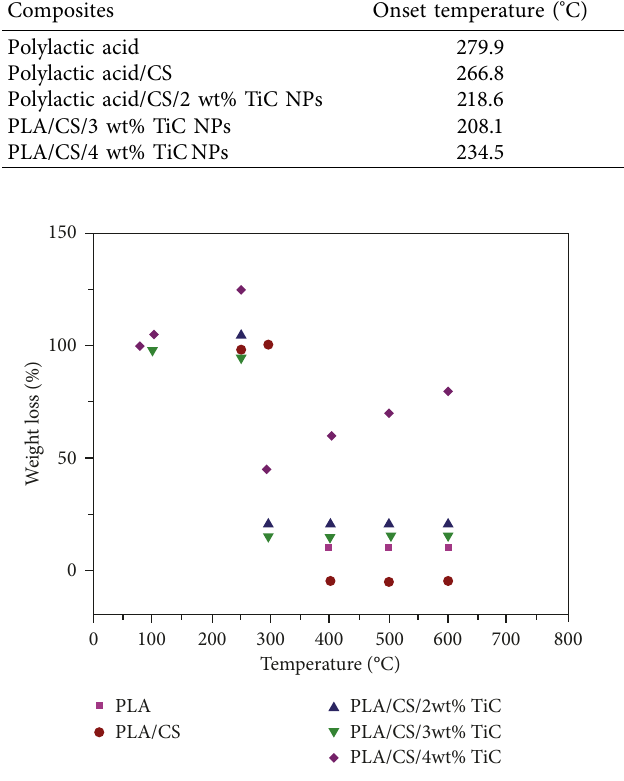
Figure 9: TGA thermograms of various composites.